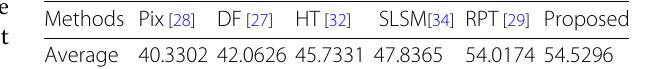
Table 2 Evaluation results of the compared methods on VOT2016 dataset: percentage of correctly tracked frames (score >